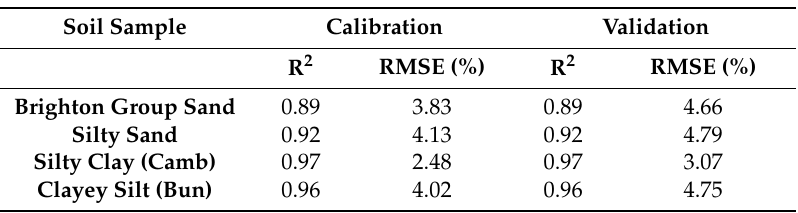
Table 9. Cross validation analysis for the AOGAN sensor for each